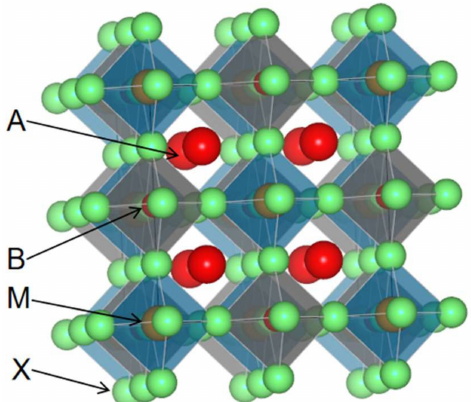
Figure 2. Structure of elpasolites (A 2 BMX 6 , where X = F, Cl, Br, I; M = Al, Sc, V, Cr, Fe, Ga, Y, In, Ln, Bi; A and B = Li, Na, K, Rb, Cs, Tl, NH 4 , Ag).